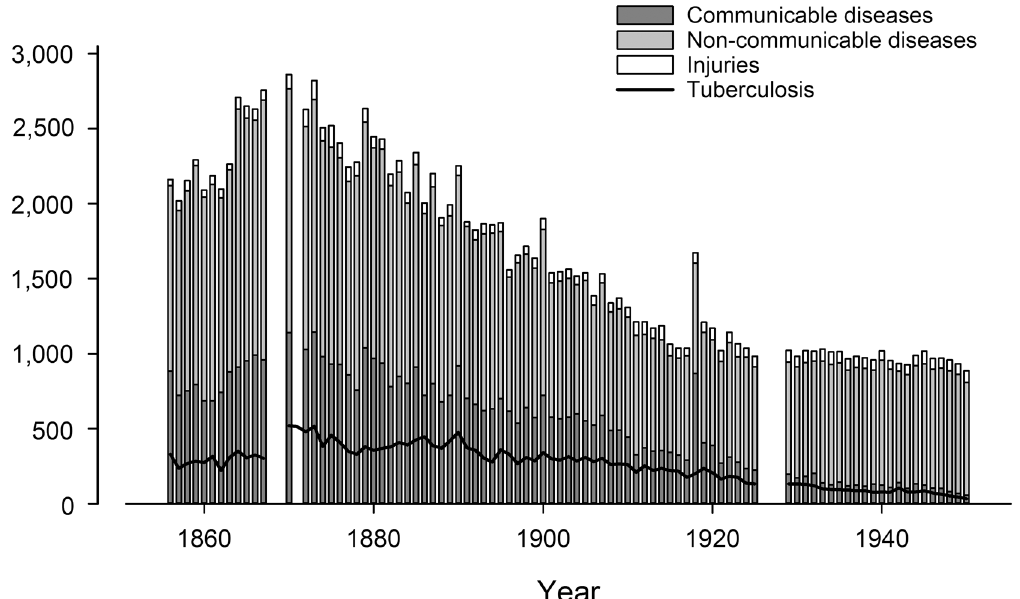
Fig 1. Changes in the mortality due to injuries (including homicide), communicable (infectious diseases and infant death) and non-communicable diseases (including cancer) in the capital city of Bern, Switzerland, between1856 and 1950. Bars represent average 5-year mortality; the black curve represents tuberculosis (TB) mortality. Data were not available for the years 1868 – 1869, 1871 and 1926 to1928.